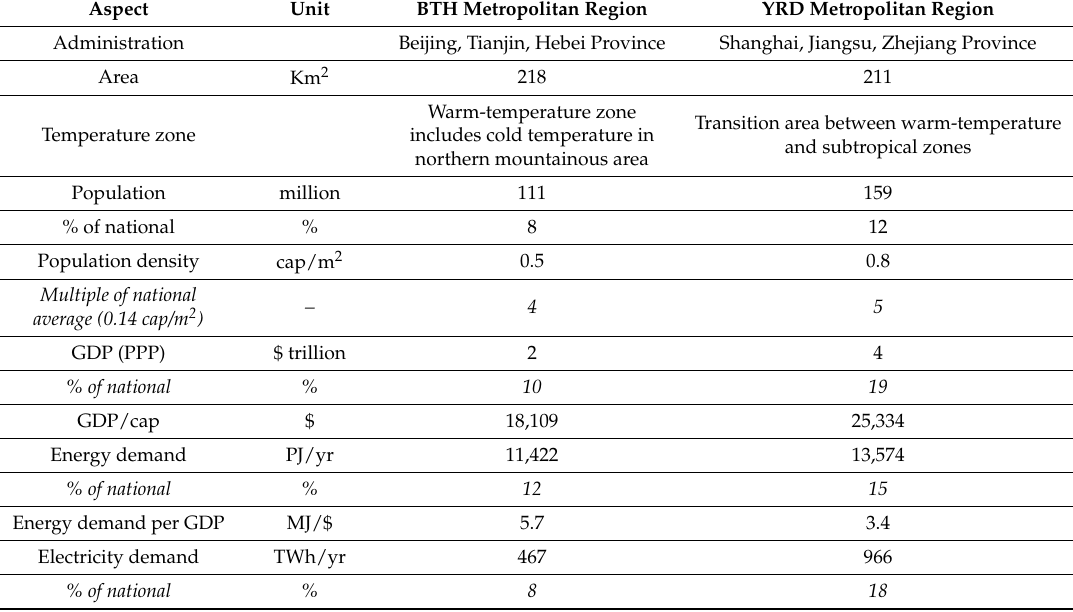
Table 1. Main characteristics of the two study regions in 2015 with comparison to national